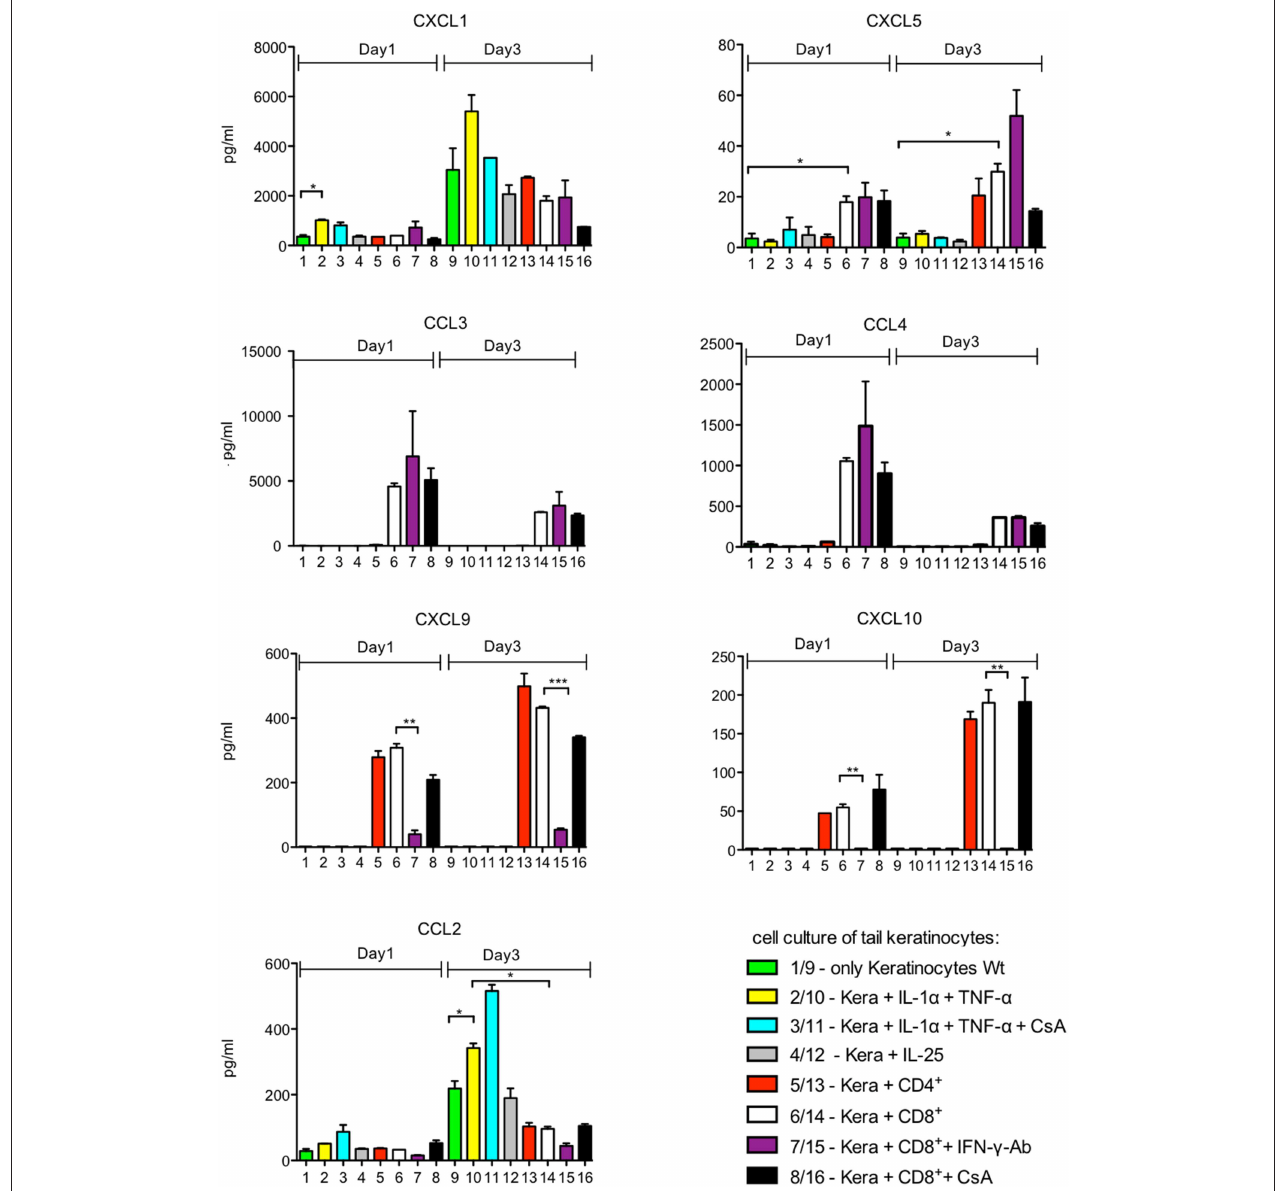
FIGURE 1 | Chemokine secretion of murine keratinocytes ex vivo . 10 5 keratinocytes cultured for 7 d in vitro were seeded in 12-well plates. They were cultivated alone (columns 1–4 and 9–12) or together with 10 5 splenic CD4 + or CD8 + T cells pre-activated for 1 d by α CD3/CD28 Abs (columns 5–8 and 13–16) for another day. Keratinocytes remained unstimulated or were stimulated by IL-1 α and/or TNF- α (30ng/ml each), CsA (100ng/ml), or IL-25 (2 µ g/ml) as indicated. In the assays 7 and 15, 5 µ g/ml of an Ab neutralizing IFN- γ was added. The supernatants of cultures were harvested and chemokine secretion was measured using